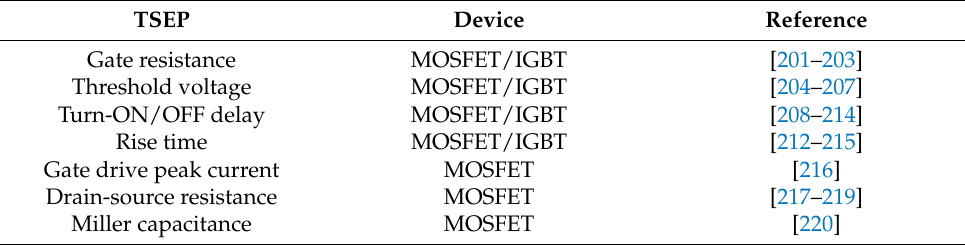
Table 6. Low-Level Control Methods for